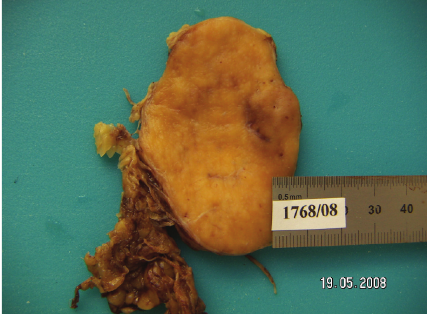
Figure 2: Retroperitoneal pararenal Castleman’s disease.